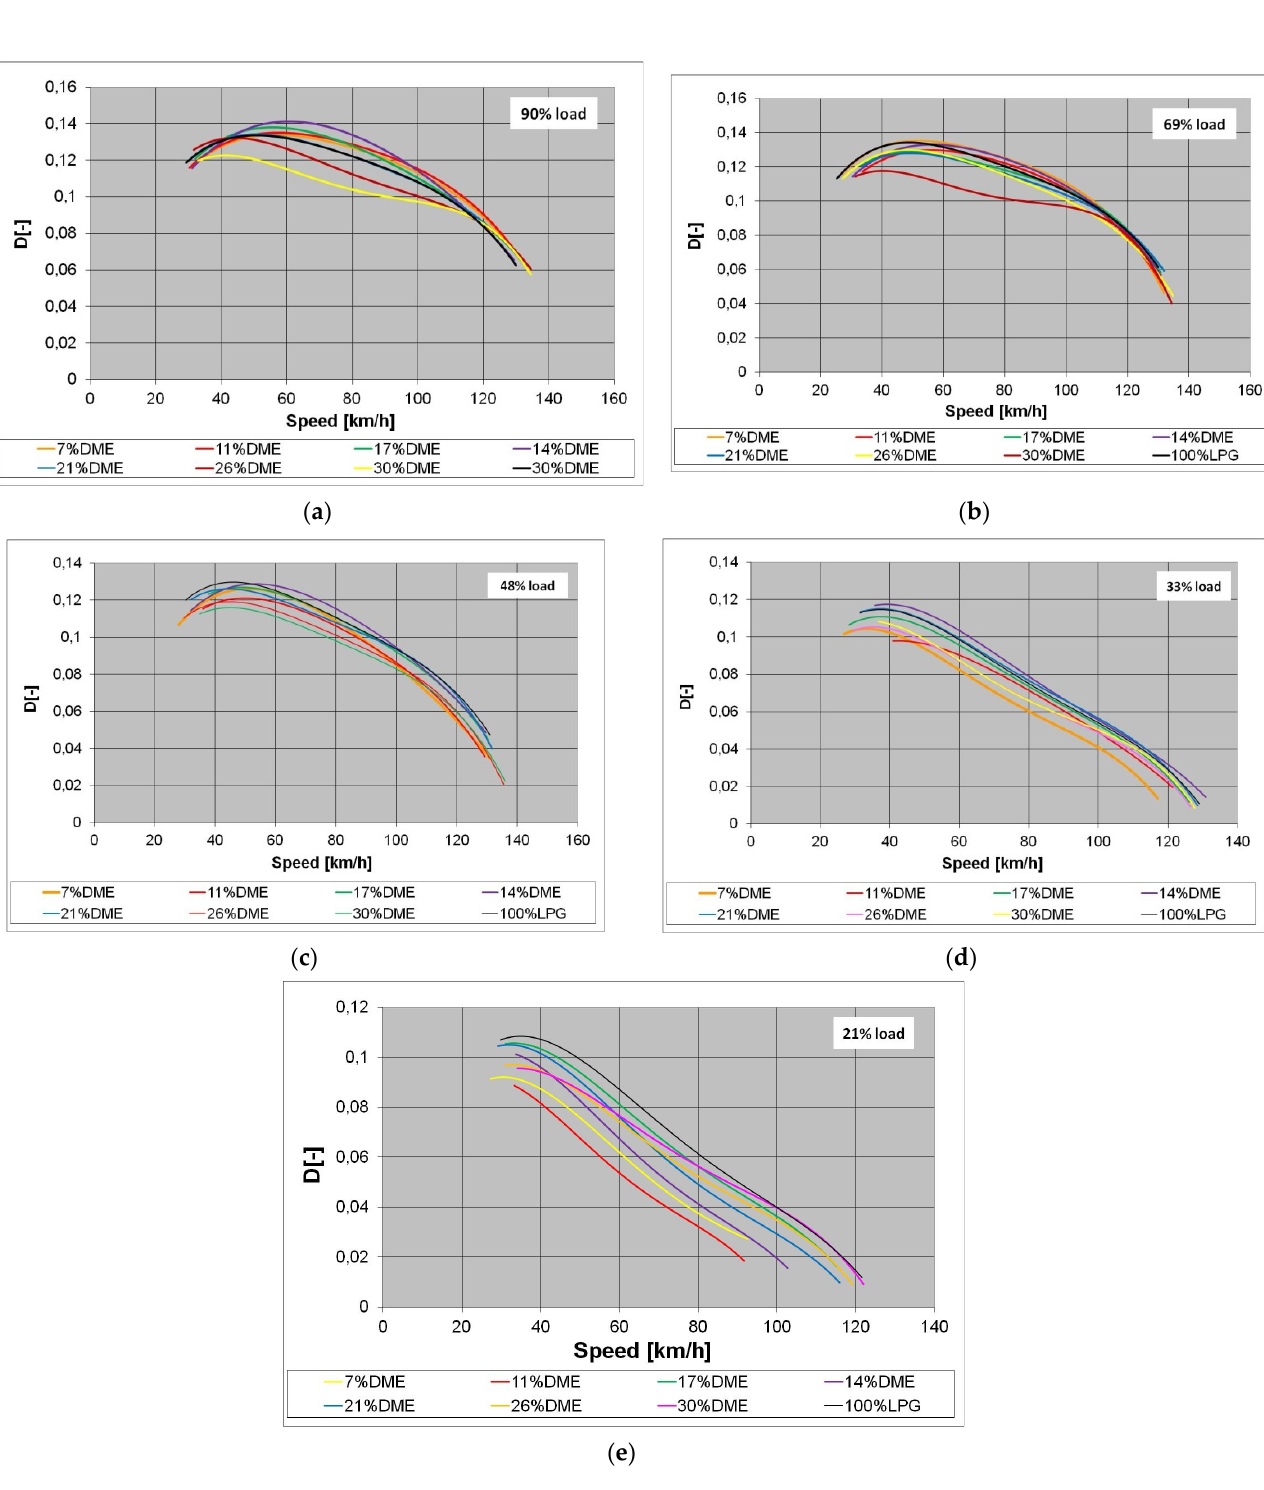
Figure 8. Maximum values of the dynamics factor for different mass fraction of DME and engine load.